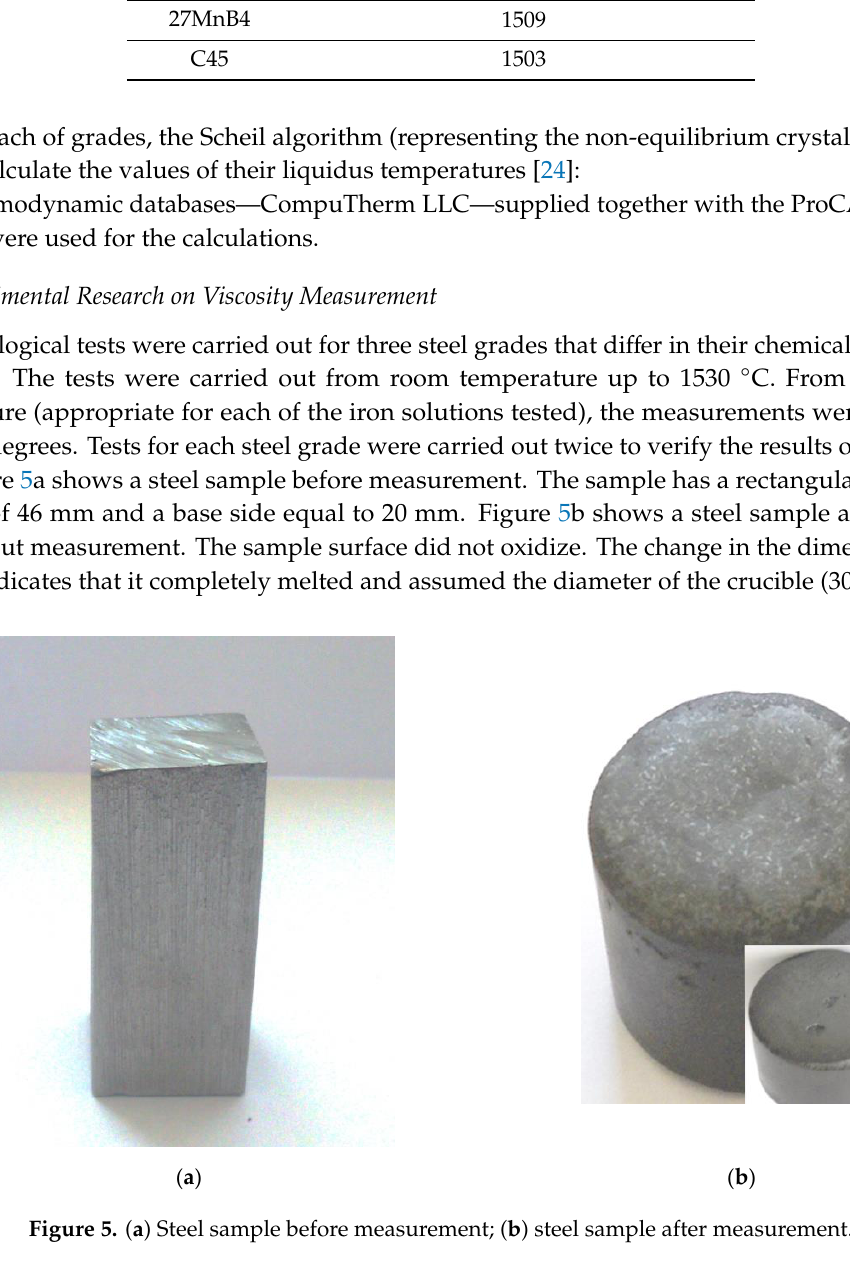
( b ) Figure 6. ( a ) Viscosity curve for 30MnB4 steel at 1530 °C; ( b ) flow curve for 30MnB4 steel at 1530 °C.